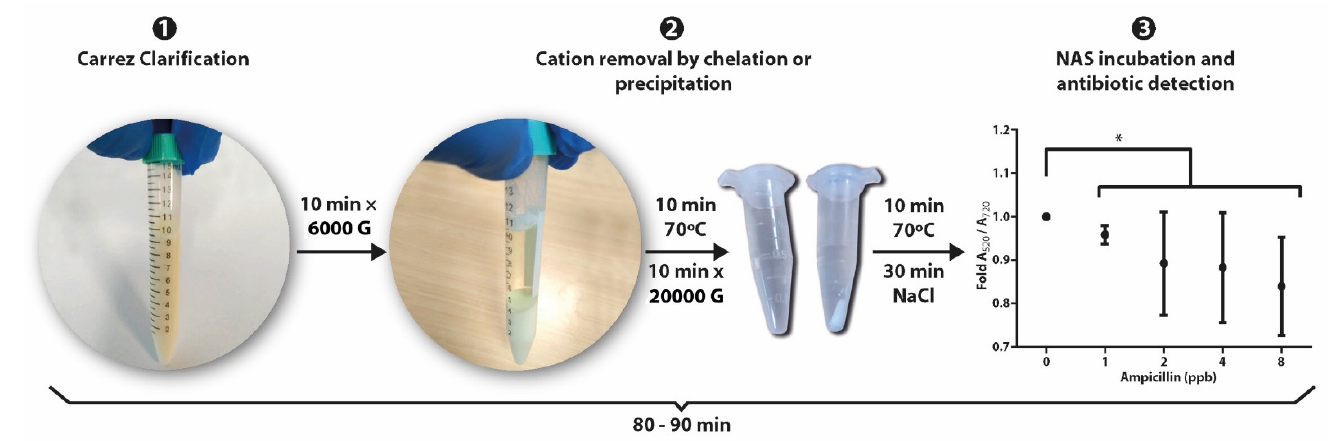
Figure 9. Preanalytical and analytical steps of the methodology developed to apply NAS technology for the detection in raw milk of kanamycin, oxytetracycline, sulfadimethoxine and ampicillin at MRL concentration